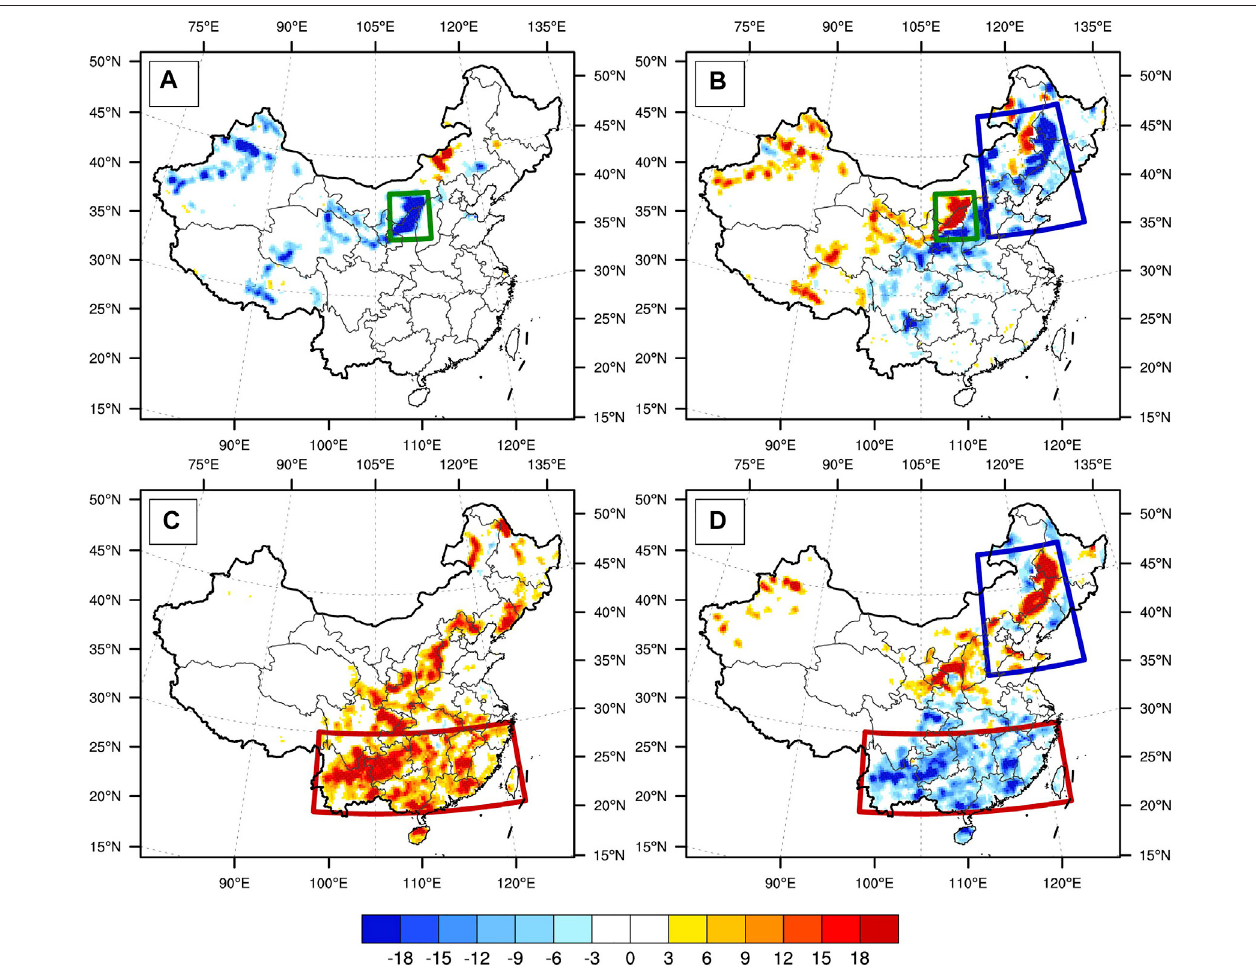
FIGURE1| ThelineartrendsoffourmajorPFTspercentagesduring1984 – 2013: (A) bareground, (B) grassland, (C) forestand (D) croplandinChina,units:%/30a. Note that the red, blue and green rectangles in the fi gure represent the main cropland-to-forest (21.5 – 30 ° N; 98 – 122 ° E), grassland-to-cropland (36 – 49 ° N; 114 – 127 ° E) and bare groud-to-grassland (36 – 41 ° N; 107 – 112.5 ° E) transition areas, respectively. All colored values in the plots are statistically signi fi cant at 95% con fi dence level.